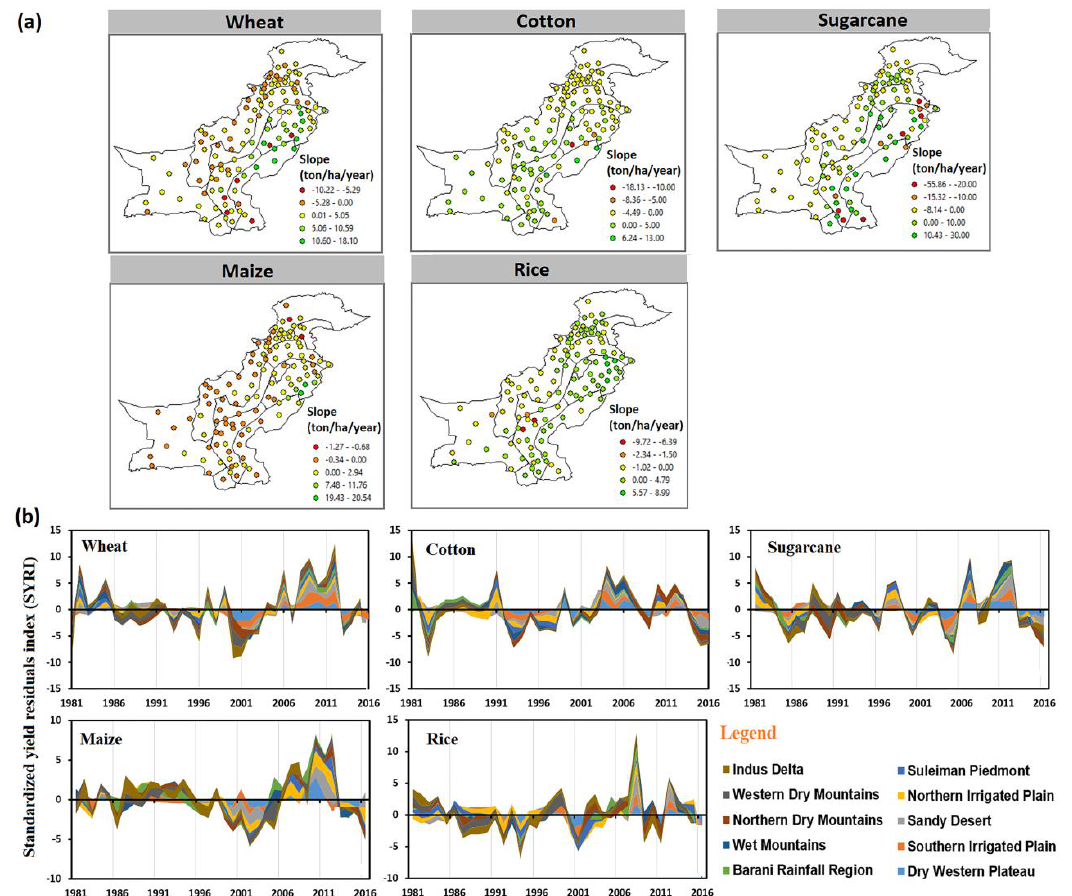
Figure 9. ( a ) The rate of change in crop yield for five major crops over 123 locations, and ( b ) com- parison between standardized crop yield residual index (SYRI) for five major crops from 1981 to 2017 over different